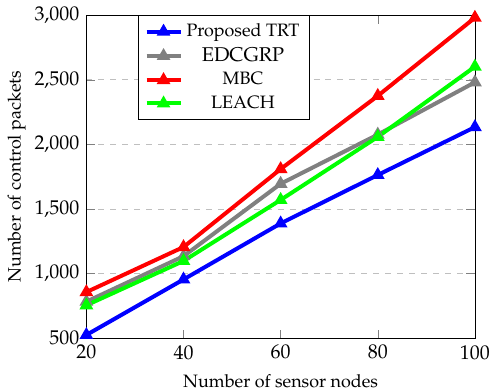
Figure 10. Control overhead vs. Number of sensor